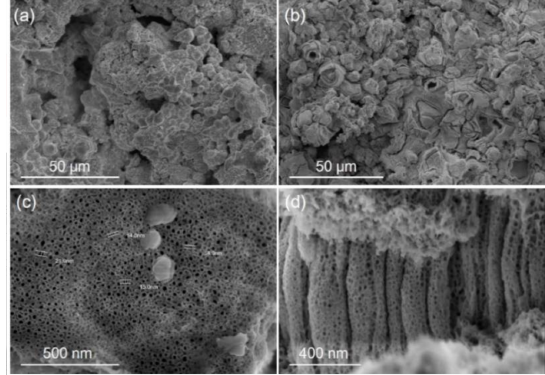
Figure 2. SEM images of as-sprayed tantalum (MT) coating surface ( a ); anodizing micro/nano tantalum (MNT) coating surface ( b ); cross-section by mechanical fracture of the sample ( c ); top view of resulting nanotube array ( d ).